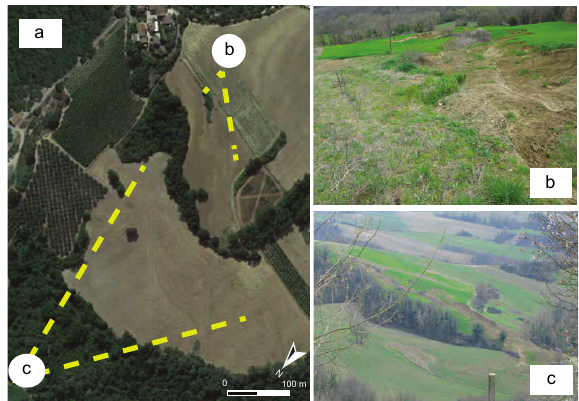
Figure 4. (a) Overview of the Assignano landslide area in Google Earth ™ taken on 8 July 2013. Photo shooting points and photograph taken (b) close to the landslide and (c) from a viewpoint. The pho- tographs taken in the field and the Google Earth ™ image were used to prepare the reconnaissance field